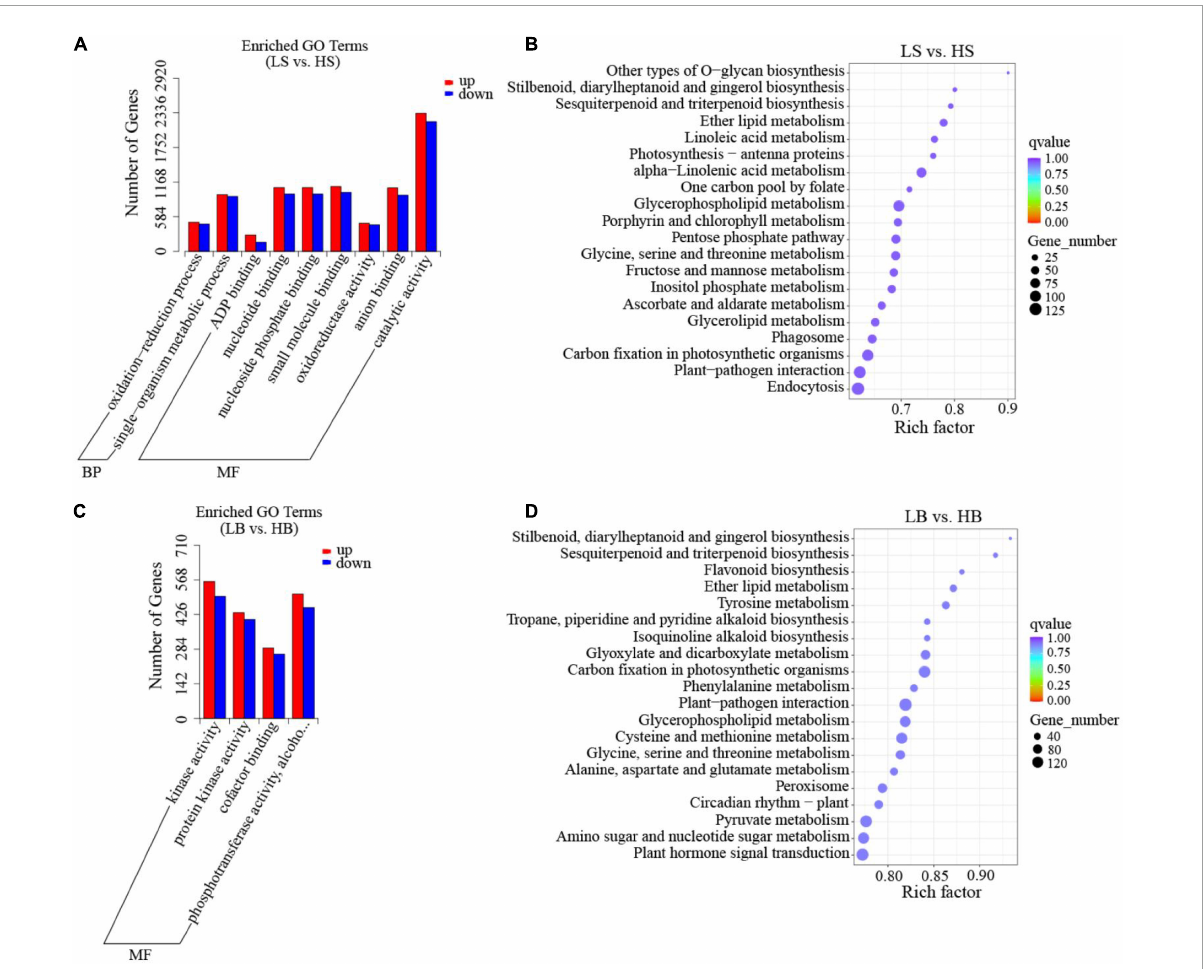
FIGURE6 GO classification and KEGG enrichment analysis of DEGs. (A) GO classification of H. ammodendron ; (B) KEGG enrichment analysis of H. ammodendron ; (C) GO classification of H. persicum ; and (D) KEGG enrichment analysis of H. persicum . LS and LB, respectively, represent H. ammodendron and H. persicum in an arid environment; HS and HB denote H. ammodendron and H. persicum , respectively, under a humid